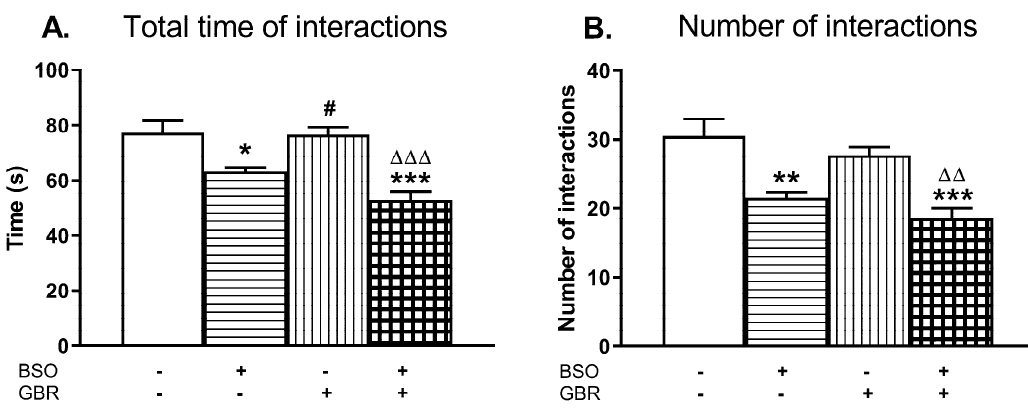
Figure 6. The e ff ects of chronic administration of BSO and GBR 12909, alone or in combination, during the early postnatal life on the social behavior assessed as the total time spent in social interactions ( A ) and as the number of interactions ( B ) in adult, 90-day-old rats. Data are presented as the mean ± SEM, n = 12 (six pairs) for each group. Statistical analysis was performed using a two-way ANOVA; symbols indicate significance of di ff erences according to the Newman–Keuls post-hoc test, * p < 0.05, ** p < 0.01, *** p < 0.001 vs. control; # p < 0.05 vs. BSO-; and ∆∆ p < 0.01, ∆∆∆ p < 0.001 vs. GBR 12909-treated groups.